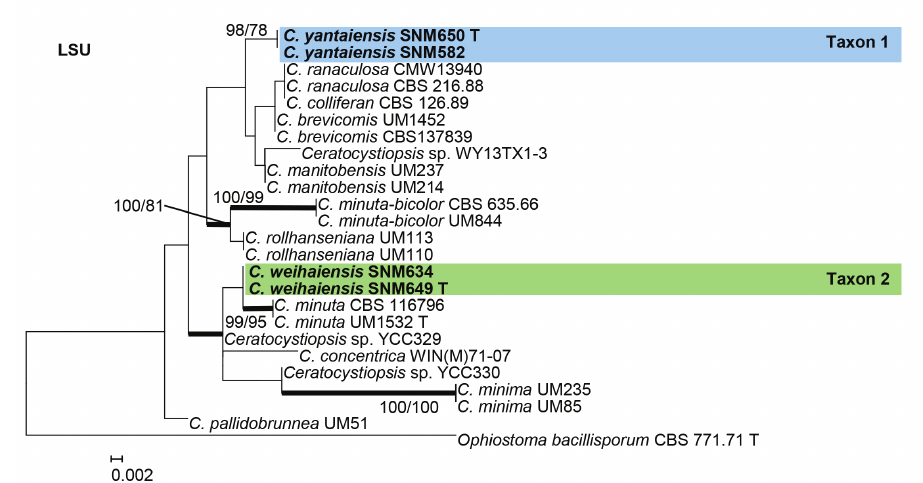
Figure 2. Maximum likelihood phylogeny of Ceratocystiopsis using partial LSU gene regions. The isolates recovered in this study are highlighted in color and in bold font. ML and MP bootstrap support val- ues ≥ 75 are indicated at the nodes as ML/MP. Bold branches indicate posterior probabilities values ≥ 0.9. T indicates ex-type